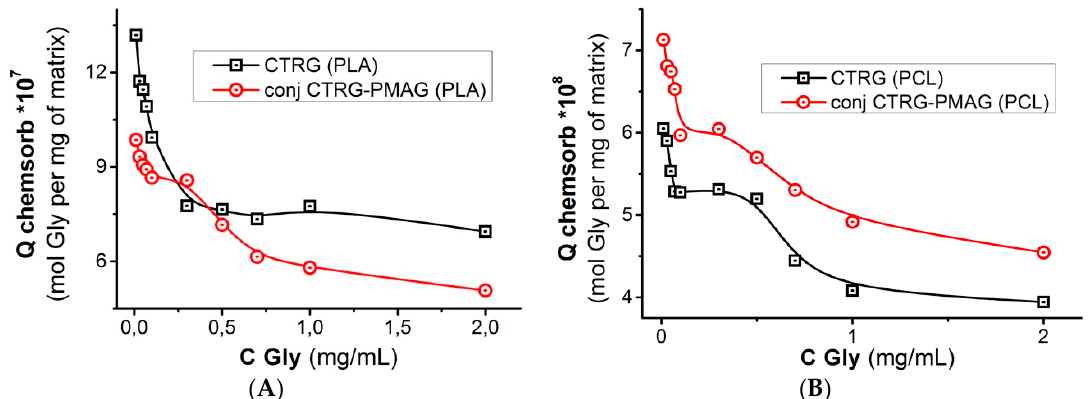
Figure 7. Dependences of Gly amount bound to the residual aldehyde groups of ox-PMAG on CTRG quantity immobilized on the surface: ( A ) PLA, ( B ) PCL. Conditions: 0.01 M sodium borate buffer solution, pH 8.5, 25 °C, 300 rpm.